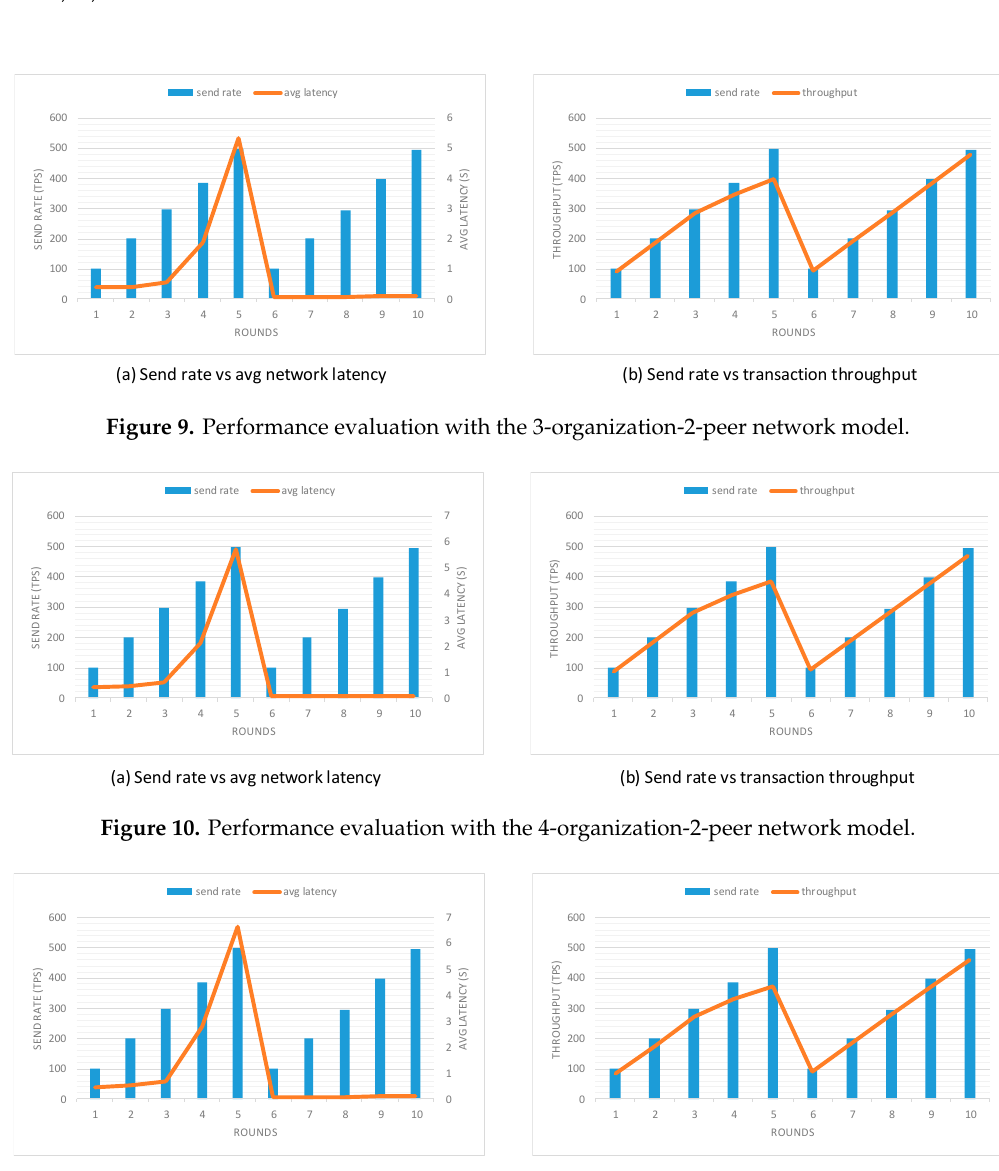
Figure 11. Performance evaluation with the 5-organization-2-peer network model.